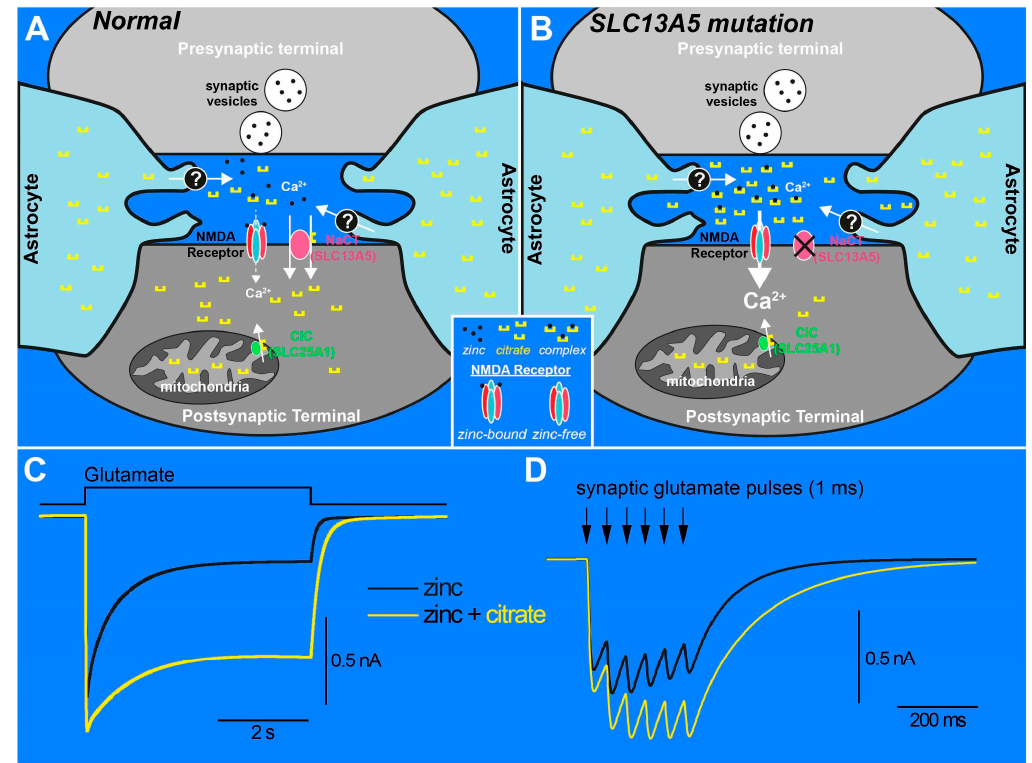
Figure 3. The possible role of zinc and NMDA receptors in loss-of-function SLC13A5 mutations. ( A ) normal condition. Astrocytes release citrate (yellow U-shaped symbols) into the extracellular space via an unknown mechanism (denoted by a question mark). The extracellular zinc binding site on the NR2A subunit (red) of the NMDA receptor is occupied by zinc ions (black filled circles), acting as a check on NMDA receptor-induced calcium influx. The plasma membrane citrate transporter NaCT (SLC13A5, pink) limits the accumulation of extracellular citrate by transporting citrate into the cytoplasm. Citrate extrusion from the mitochondria via the mitochondrial citrate carrier (CIC or SLC25A1, green) is also a source of cytosolic citrate; ( B ) When SLC13A5 function is lost, intracellular citrate levels are likely reduced while extracellular citrate levels rise to pathologically high levels. Citrate chelation of free zinc reduces the availability of zinc for the NMDA receptor, relieving the negative allosteric effect of zinc on NMDA receptor function, thereby increasing calcium flux through the NMDA receptor (note larger arrow indicating enhanced flux of calcium through the NMDA receptor). Schematics in A and B were motivated from [30,61]; ( C ) kinetic model simulations [55,62] of NMDA receptor currents generated by a 5 s pulse of glutamate under normal conditions (i.e., with free zinc) and under conditions in which extracellular citrate has chelated free zinc (i.e., without free zinc). Citrate chelation induces a larger and more sustained NMDA receptor current; ( D ) response